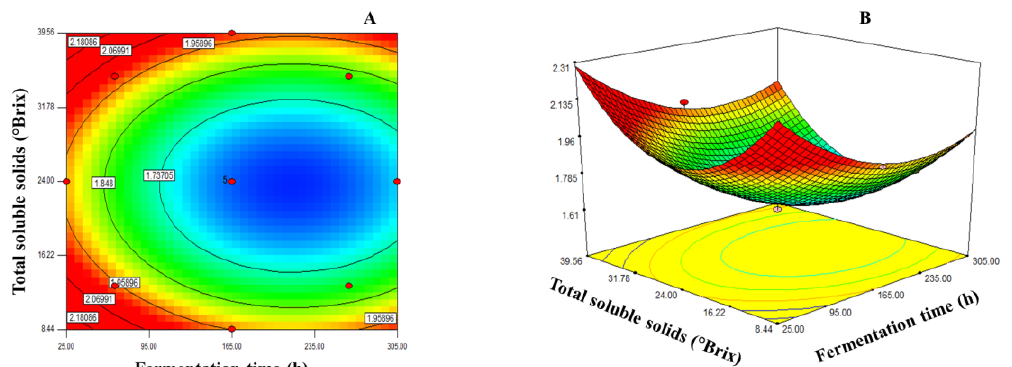
Figure 3. Contour plots and response surface ( A , B ) for the effect of fermentation time (h) and total soluble solids (°Brix) on process yield of chitosan.